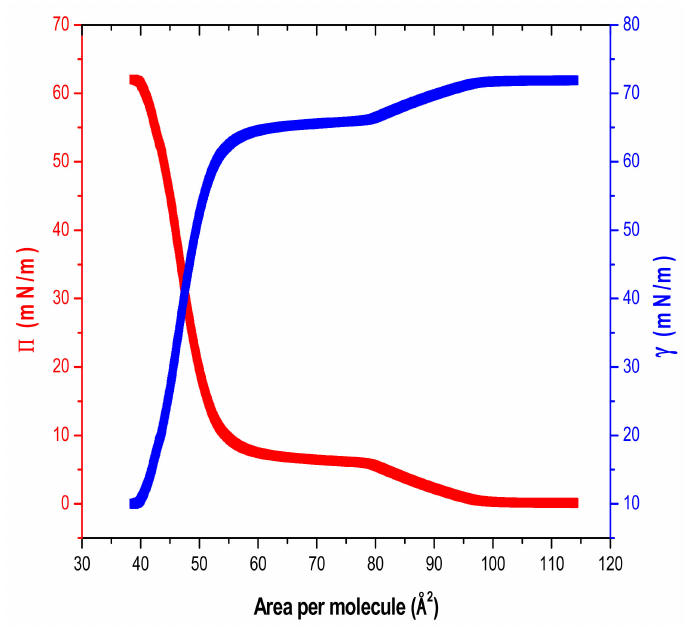
Figure 2. Surface pressure (red line) and surface tension (blue line) vs. area per molecule for DPPC below the critical